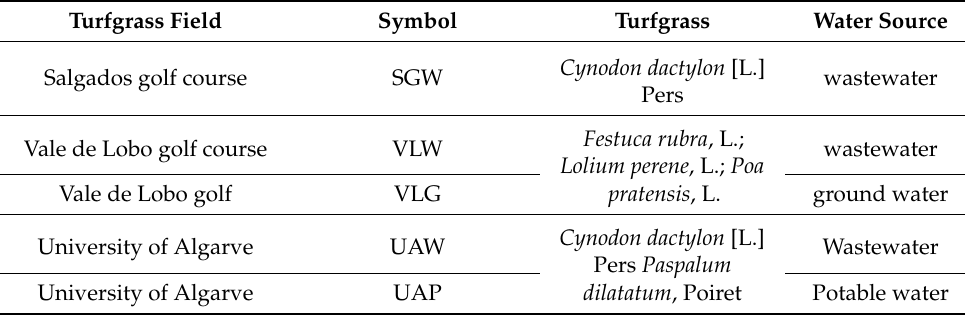
Table 1. Turfgrass fields—symbols cultivars and irrigation water source. Turfgrass Field Symbol Turfgrass